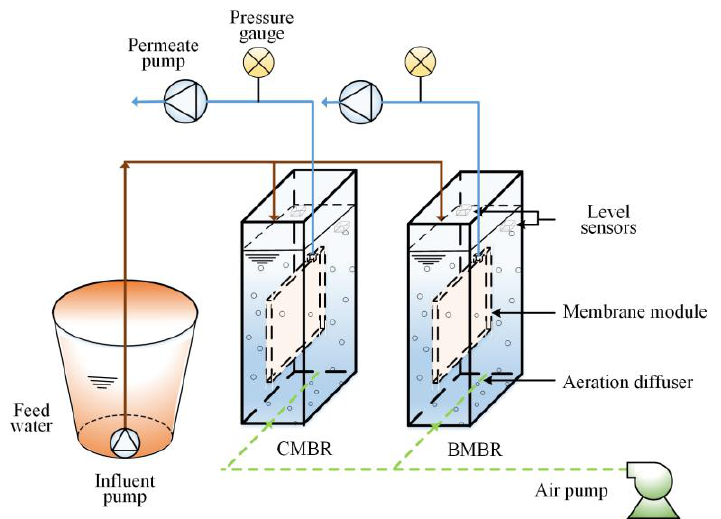
Figure 1. The schematic diagram of the experiment rig (CMBR: control MBR, BMBR: biochar MBR).